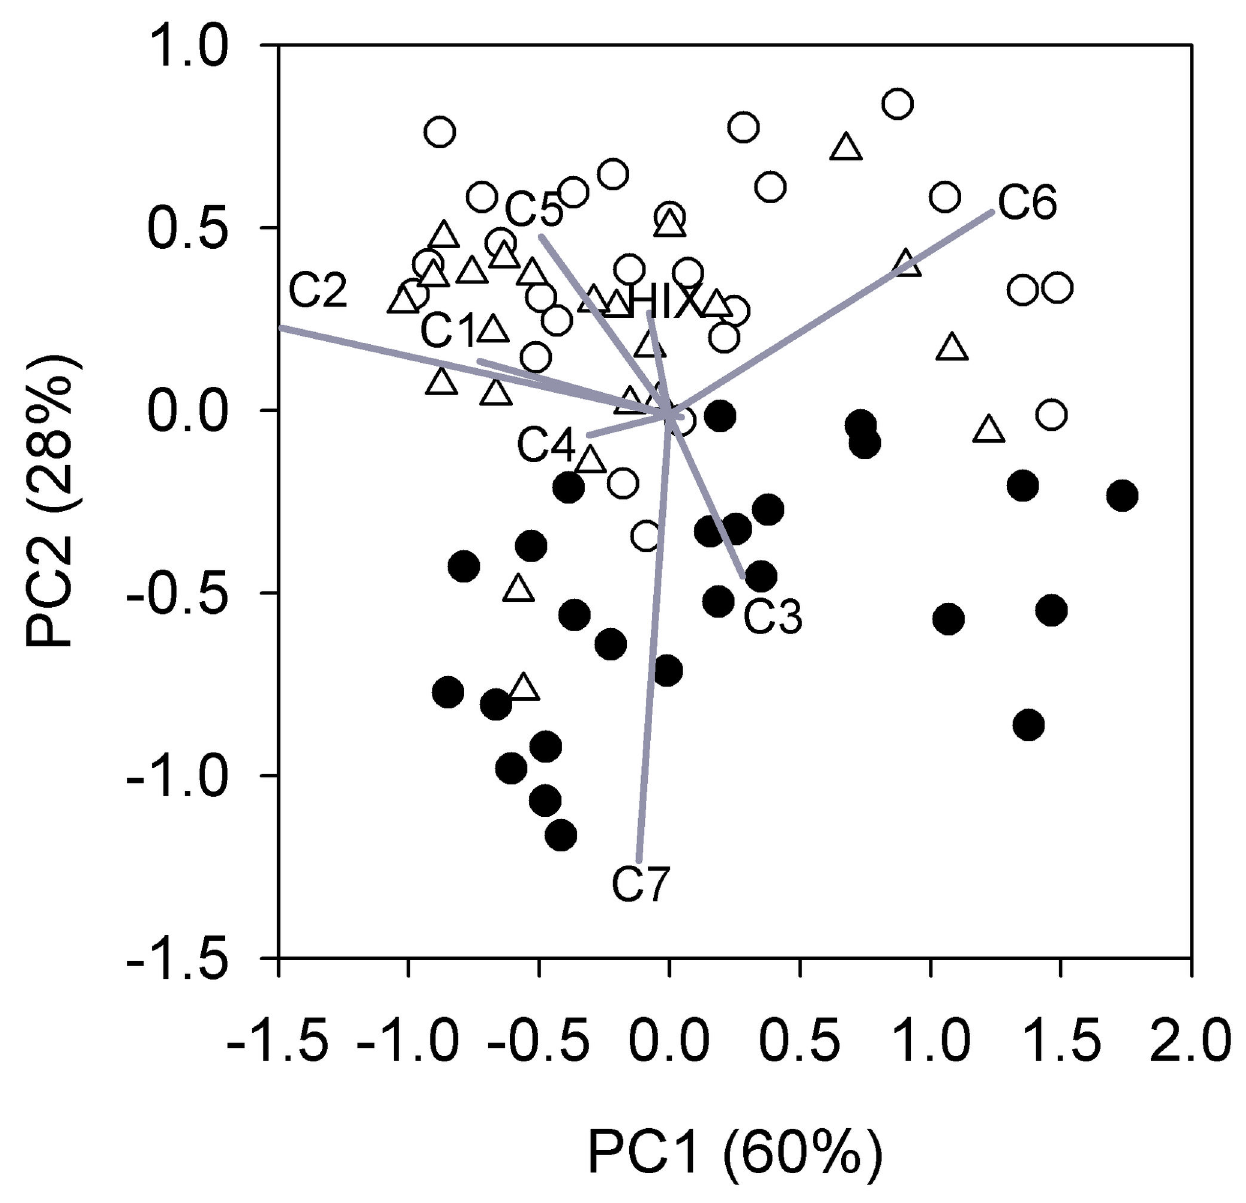
Figure 5. Principle components plot with vector loadings for the fluorescent DOM pool. MANOVA with post hoc test indicated that the light exposed fluorescent DOM pool (closed circles) was significantly different than initial (open circles) and dark (triangles) pools, which did not differ. Note, vector loadings for β:α and FI were near the origin in the first two PCA dimensions and are not displayed in this